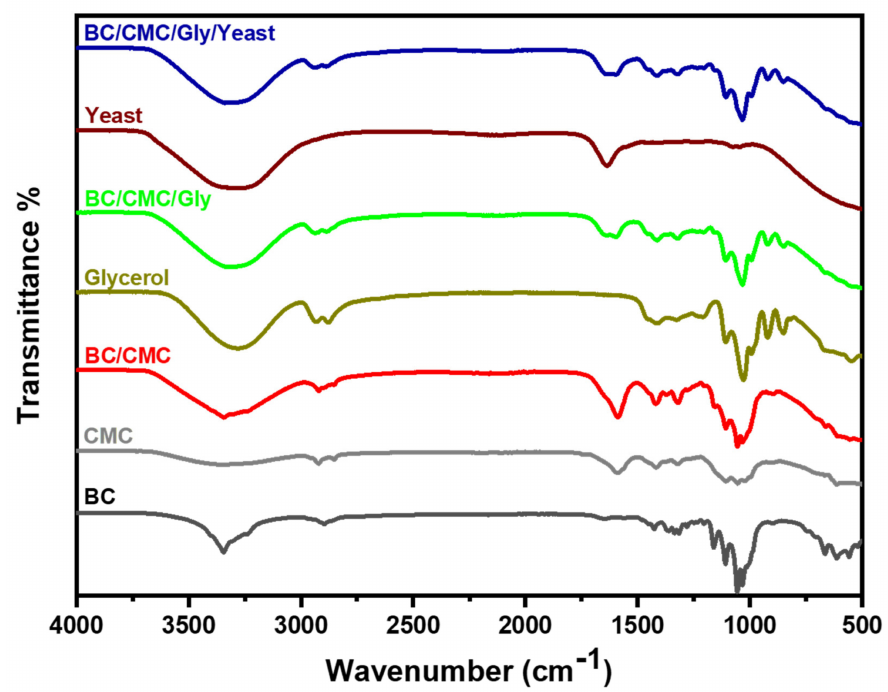
Figure 3. FT-IR spectra of pristine BC, CMC, BC/CMC, glycerol, BC/CMC/Gly, yeast, and